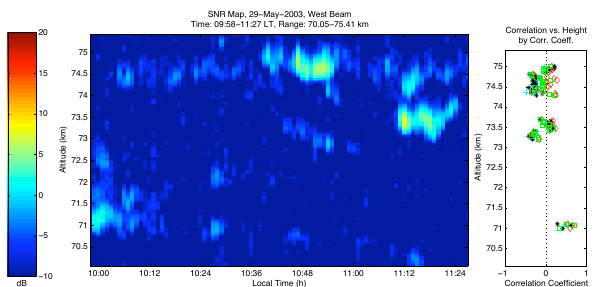
Fig. 9. Thin structures at 71.5, 72. 8, 73.5, and 74.8 km on May 29